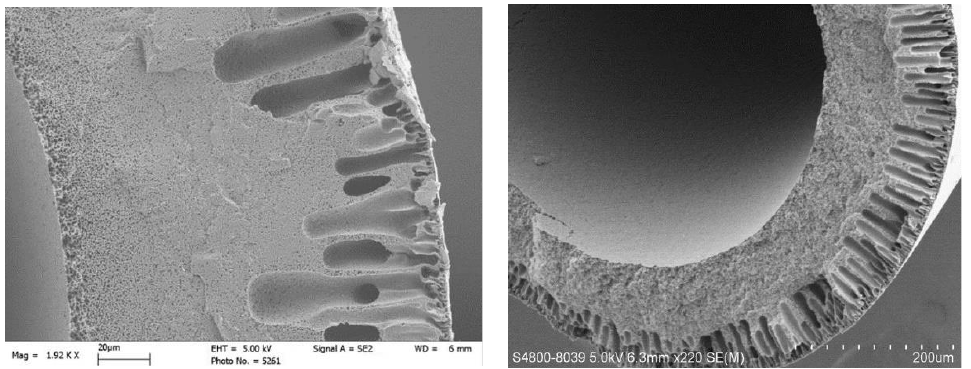
Figure 2. Cross-section and inner surface of the PTFE hollow